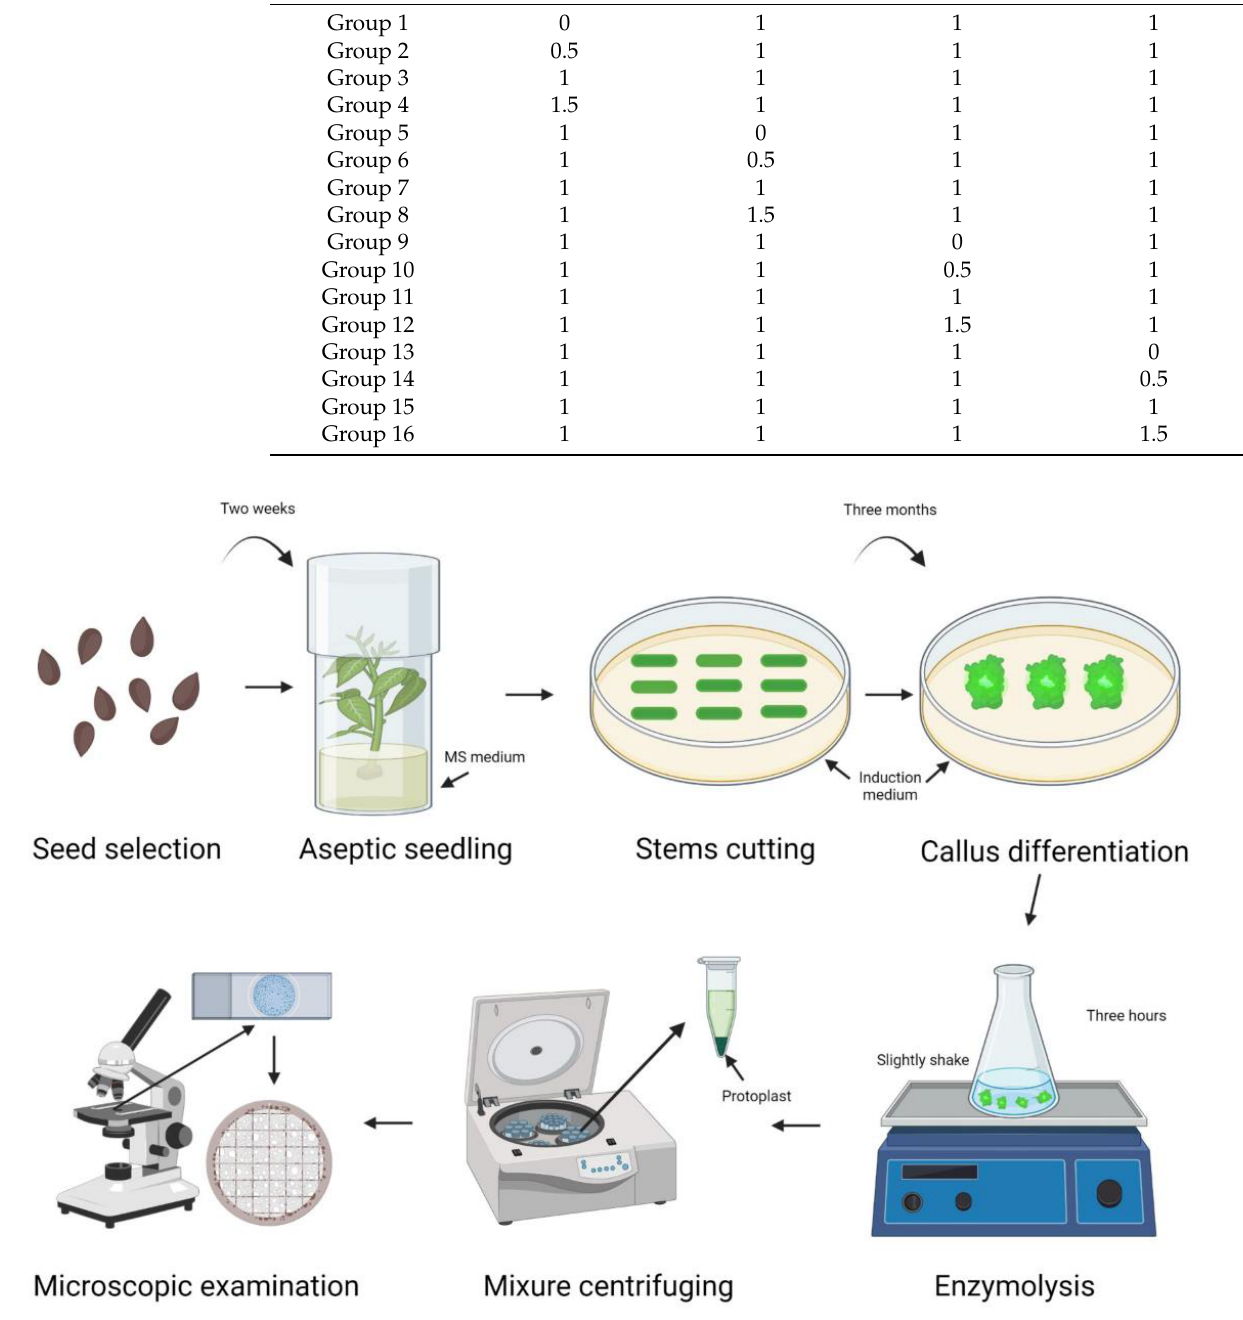
Figure 1. Schematic illustration of protoplast isolation protocol. Very few protoplasts were extracted with 0% pectinase, clearly indicating the im- portance of pectinase in this extraction. The number of protoplasts increased with the Table 1. The concentration of four enzymes used in different groups. increase in pectinase concentration. There was not a significant difference in the number of protoplasts extracted with 0.5% vs. 1% pectinase, but a concentration of 1.5% pectinase Group Cellulase Pectase Macerozym Hemicellulase greatly improved the number of protoplasts extracted (Figure 2b). Protoplast activity was Group 1 comparable at 0.5%, 1%, and 1.5% pectinase (Figure 3b). Therefore, the extraction was best with 1.5%